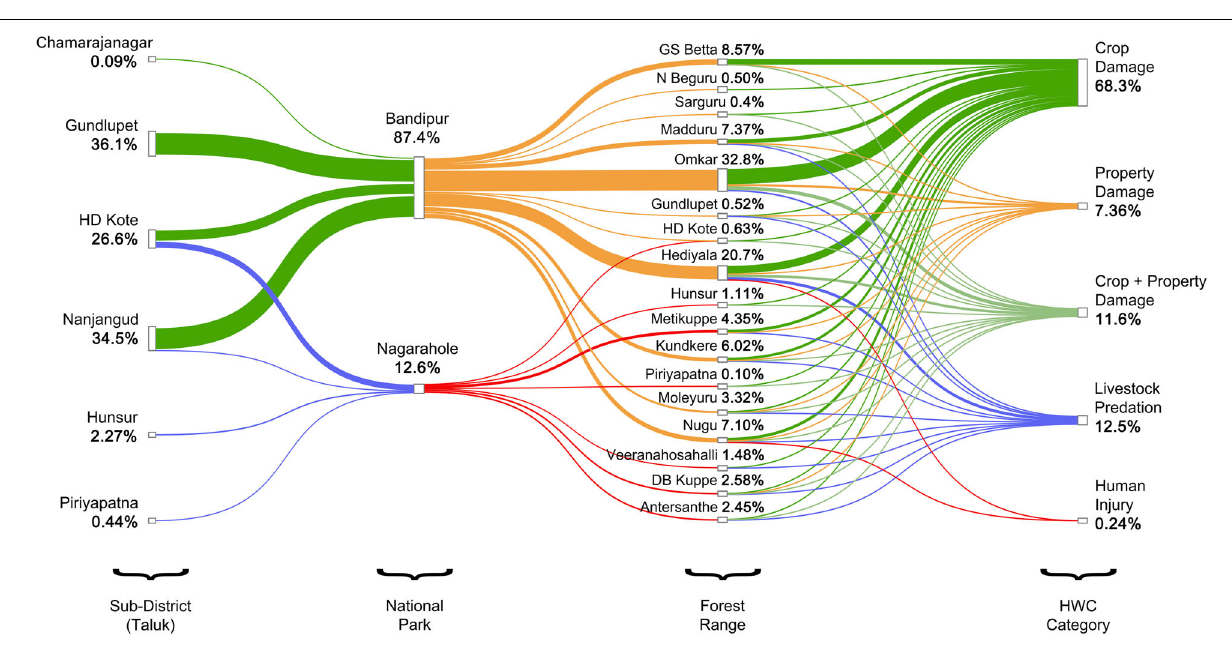
FIGURE 5 | Flow diagram depicting the percentage of total ex-gratia payment (US $157,474) matched from state government provided “OM Sheet” copies to Wild Seve cases across administrative domains and HWC